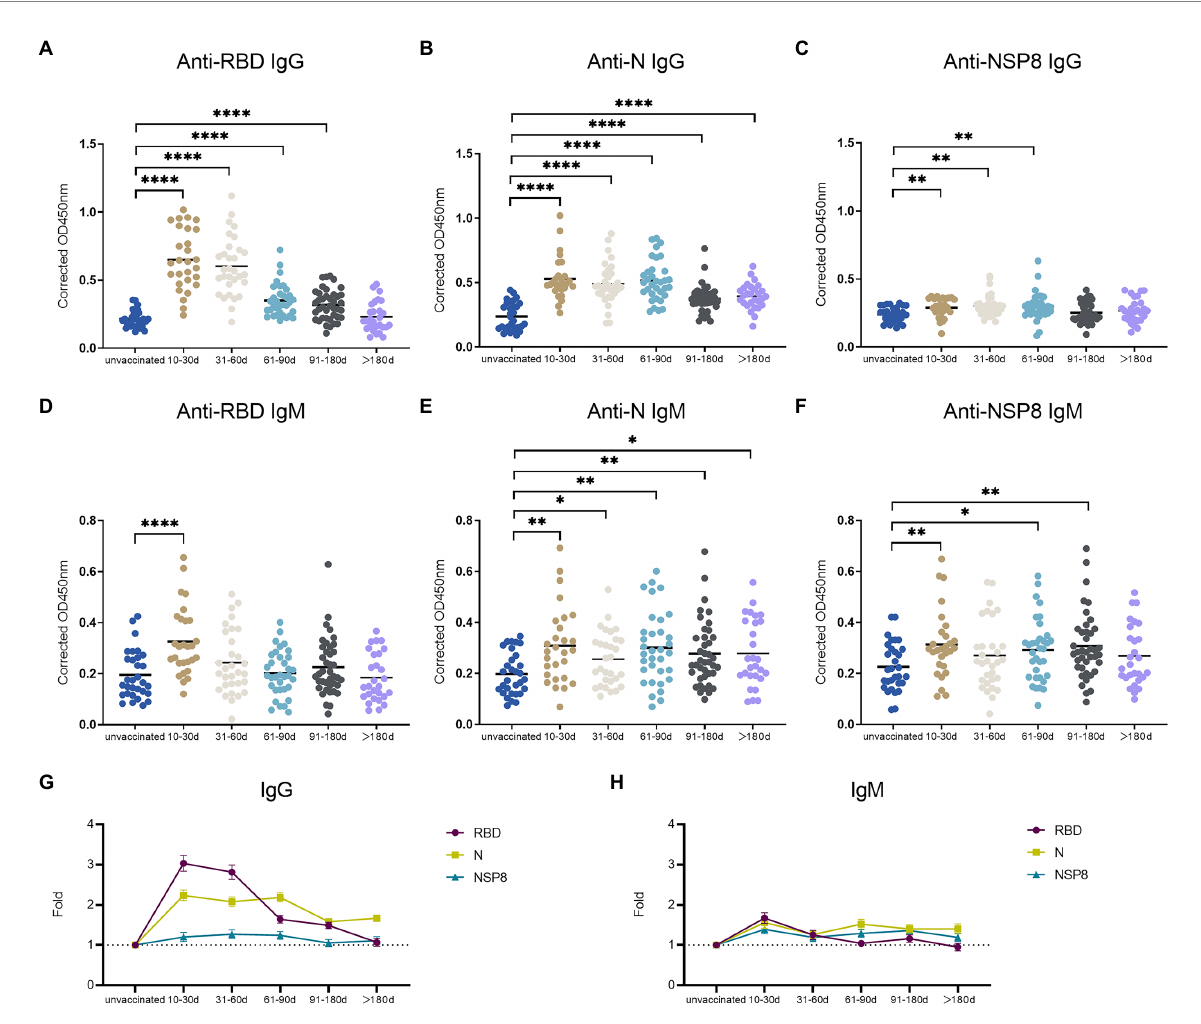
FIGURE 3 SARS-CoV-2 specific antibody responses after the 2 nd dose of vaccination. (A–C) SARS-CoV-2 specific IgG responses to RBD protein (A) , N protein (B) , and NSP8 (C) . (D–F) SARS-CoV-2 specific IgM responses to RBD protein (D) , N protein (E) , and NSP8 (F) . Serums were collected from 10– 30 days ( n = 28), 31–60 days ( n = 31), 61–90 days ( n = 34), 91–180 days ( n = 40) and >180 days ( n = 28) group post the 2 nd dose vaccination with unvaccinated group (n = 31) as control. The p -value was calculated by Student’s t -test or Mann–Whitney test. Only differences from the unvaccinated group were shown. (G,H) Summary dynamics of specific IgG (G) and IgM (H) responses induced by different SARS-CoV-2 antigens after the 2 nd dose vaccination with unvaccinated group as control. The X-axis represents the period after two doses of vaccine were administered. The Y-axis shows the ratio to the mean of the unvaccinated group shown as mean ±